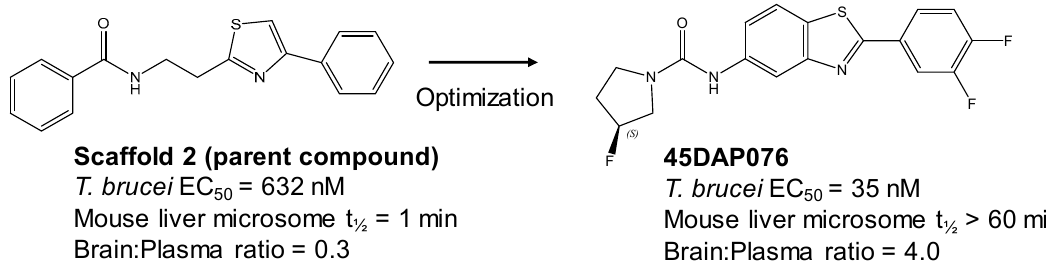
Figure 4. Sca ff old 2: Optimization of hit “thiazole” compound to lead compound Figure 4. Scaffold 2: Optimization of hit “thiazole” compound to lead compound 45DAP076.